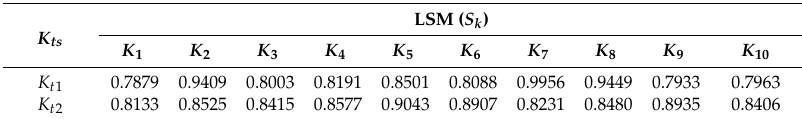
Table 6. LSM values between K k ( k = 1, 2, . . . , 10) and K ts ( s = 1, 2).